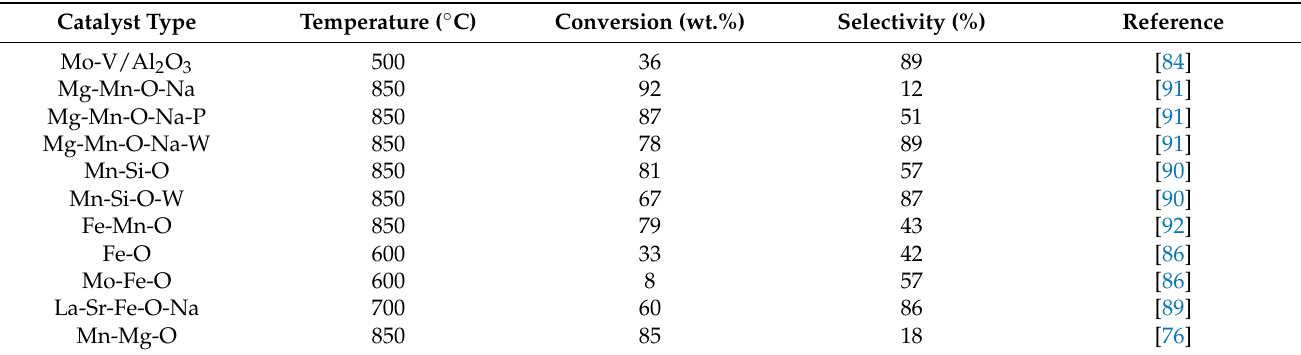
Table 6. Catalytic performance of the different